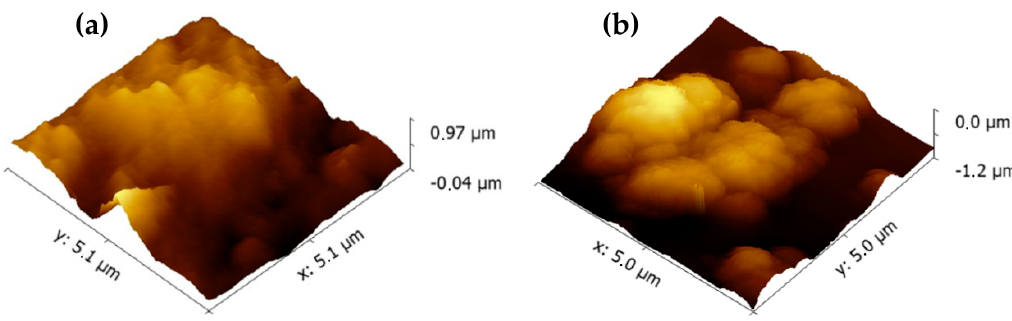
Figure 6. 3D images of PP@TiO 2 ( a ) and PP@rGO-TiO 2 ( b ) photocatalysts. Table 1. R a and W max values for PP@TiO 2 and PP@rGO-TiO 2 photocatalysts.